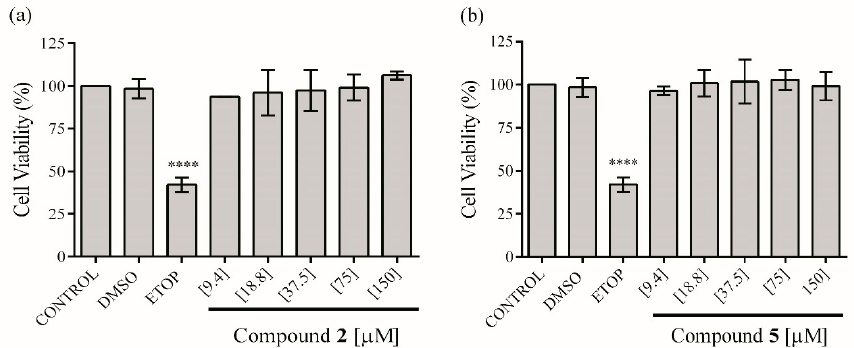
Figure 3. Effect of compounds 2 ( a ) and 5 ( b ) on the viability of RAW 264.7 cells. The values are expressed as the mean ± SD of three independent experiments ( n = 3). Significance was determined using ANOVA followed by Dunnett’s multiple comparisons test (**** p < 0.0001 DMSO, ETOP (etoposide) and compounds compared with control group).